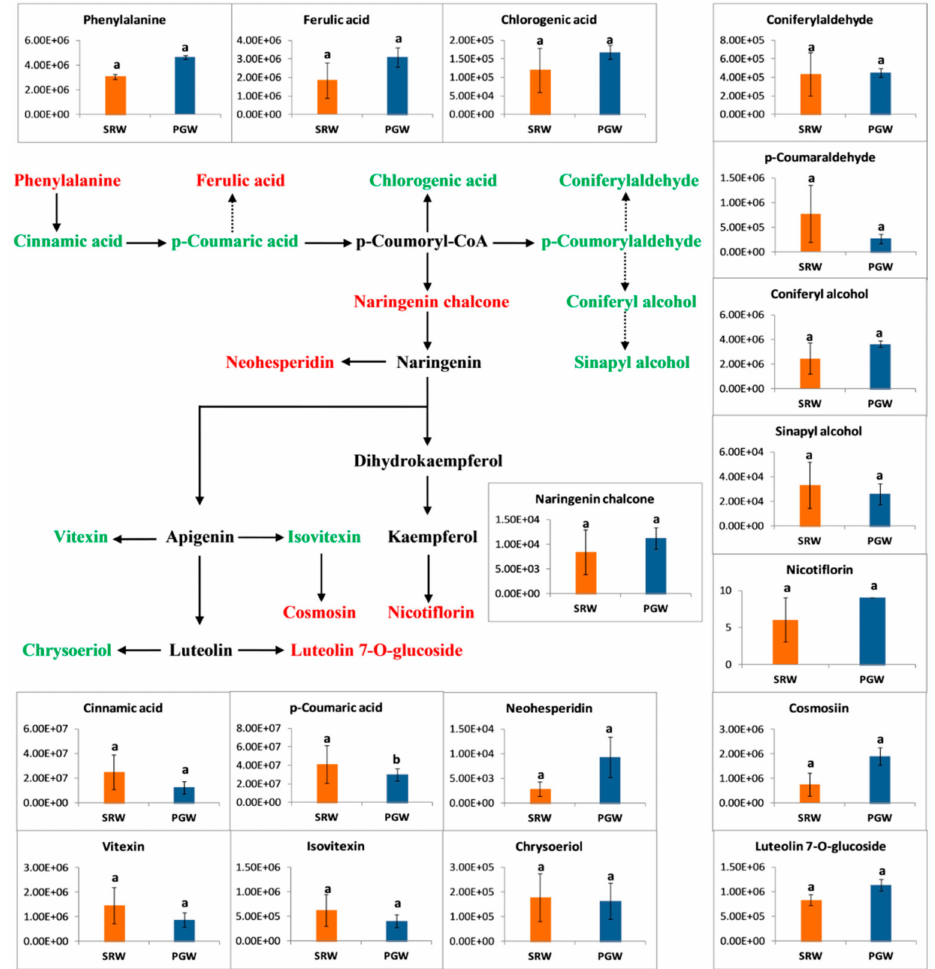
Figure 7. Y -axis shows the differences among therelative contents of intermediates of phenyl- propanoid pathway between mature fruit of pumpkin-grafted watermelon (PGW) and self-rooted watermelon (SRW). Red or green color shows the higher content of amino acids in PGW or SRW, respectively. Vertical bars represent standard error among three independent replicates. Data are the mean ± SE of three replicates. Different lowercase letters indicate significant differences at p <